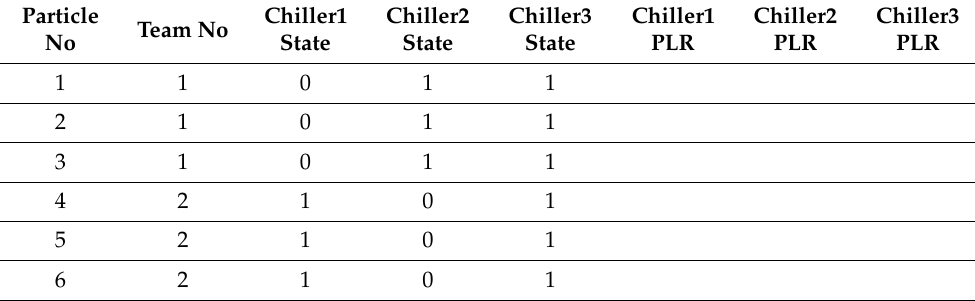
Table 2. Step 2: set up the random on-off states of chillers for each team.